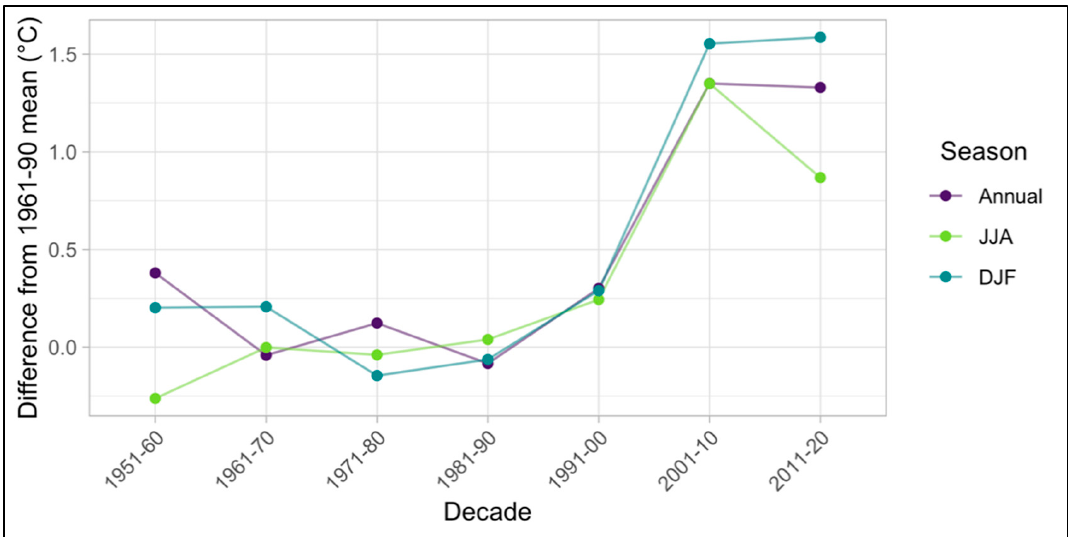
Figure 5. Temperature anomaly for each decade, 1951–2020, Westfjords average (average created